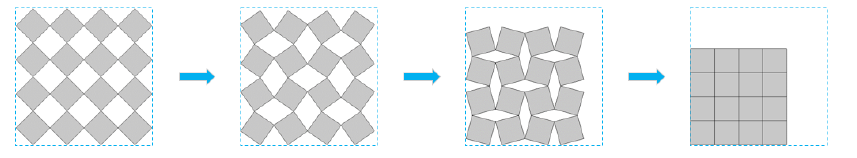
Figure 1. Base mechanism for rotating square structures. Configurations for different angles between adjacent squares (Respectively from left to right: 45°, 30°, 15°, 0°).